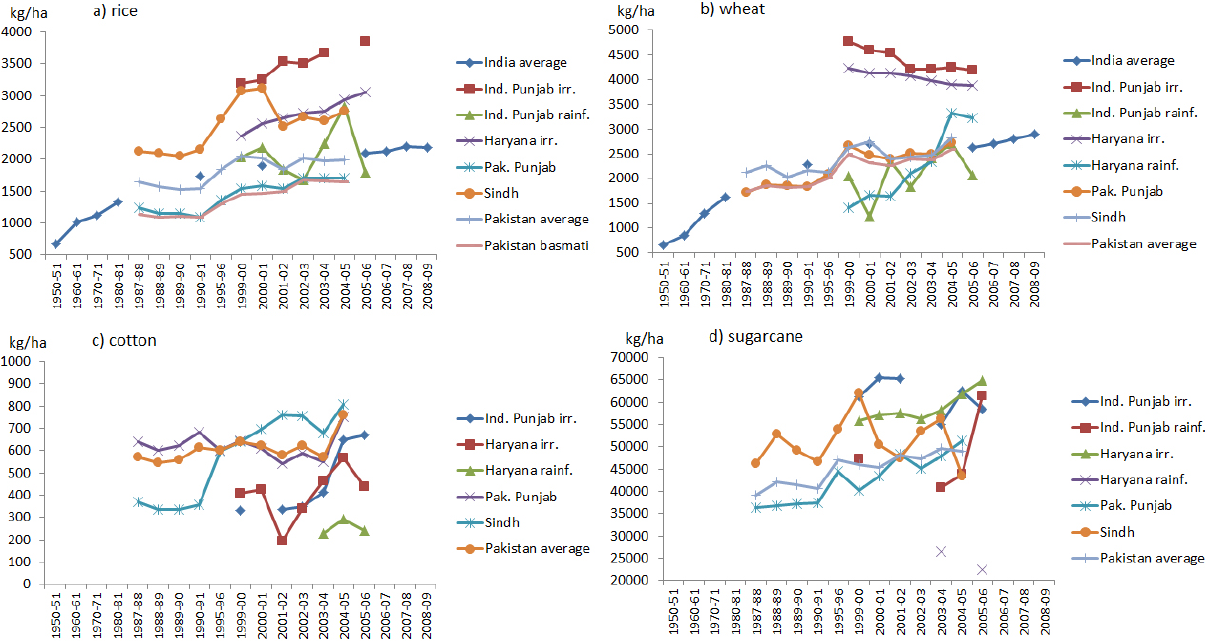
Fig. 9. Yield (in kg per ha) in selected states/regions in the Indus basin and national averages (India and Pakistan) for the period 1950–1951 to 2008–2009 of (a) rice; (b) wheat; (c) cotton and (d) sugarcane. Data sources: for Pakistan (GOP, 2005), for India (CWC,